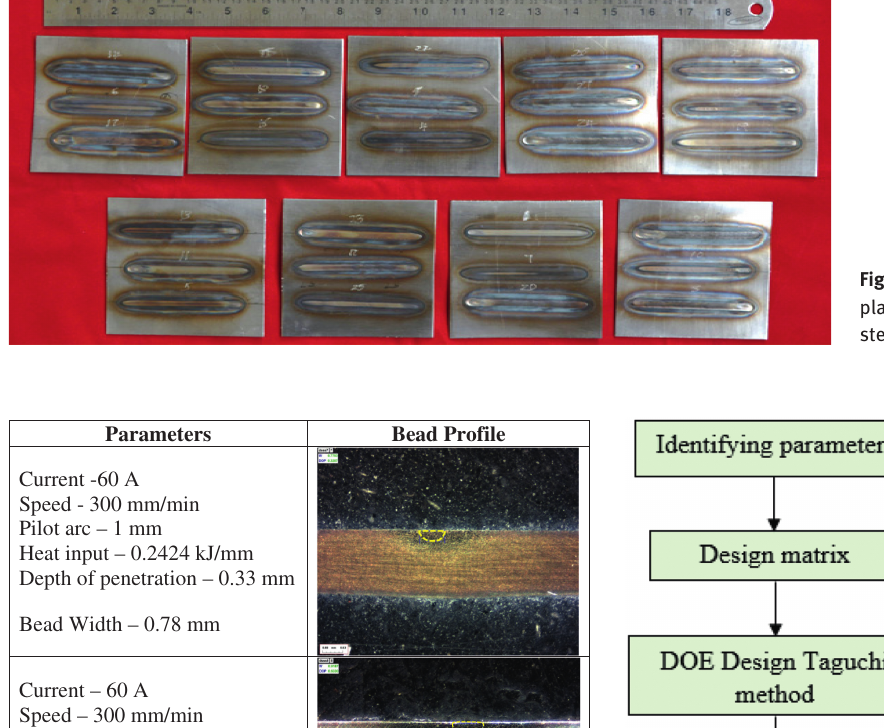
Figure 2: Depth of penetration for bead on plate trials for 2205 duplex stainless steel.